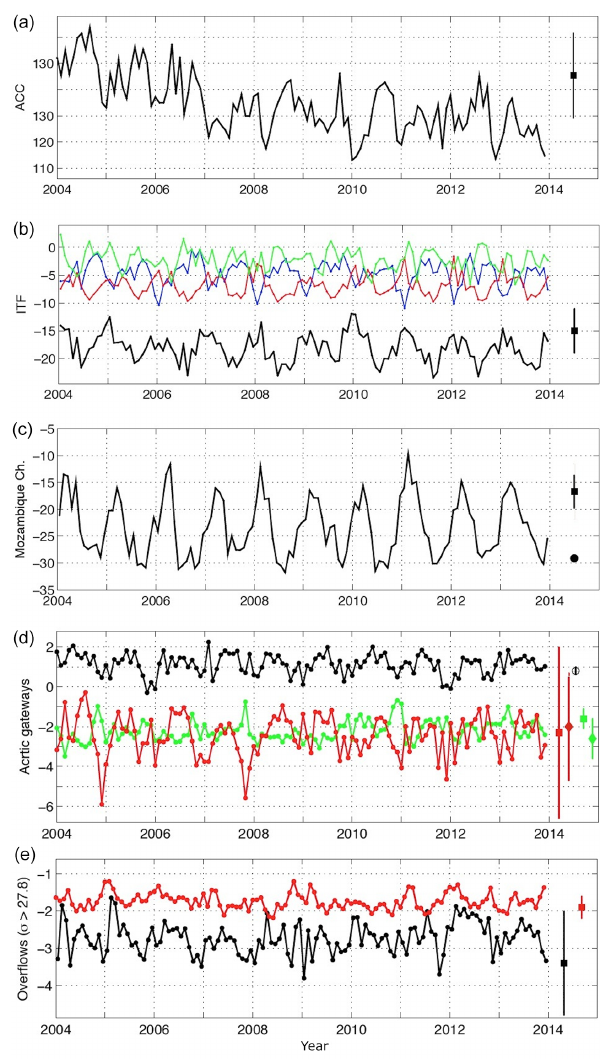
Figure 5. Time series of the monthly averaged volume transport (in Sv) of the (a) Antarctic Circumpolar Current (ACC), (b) total Indonesian throughflow (ITF) (decomposed in (red) Timor passage, (blue) Ombai strait, (green) Lombok strait), through the (c) Mozam- bique Channel, (d) Bering Strait (black), Fram Strait (red), and Davis Strait (green), and (e) for dense overflow through Denmark Strait (black) and Faroe Bank Channel (red). Observed values with error bars (as reported in Table 2) are